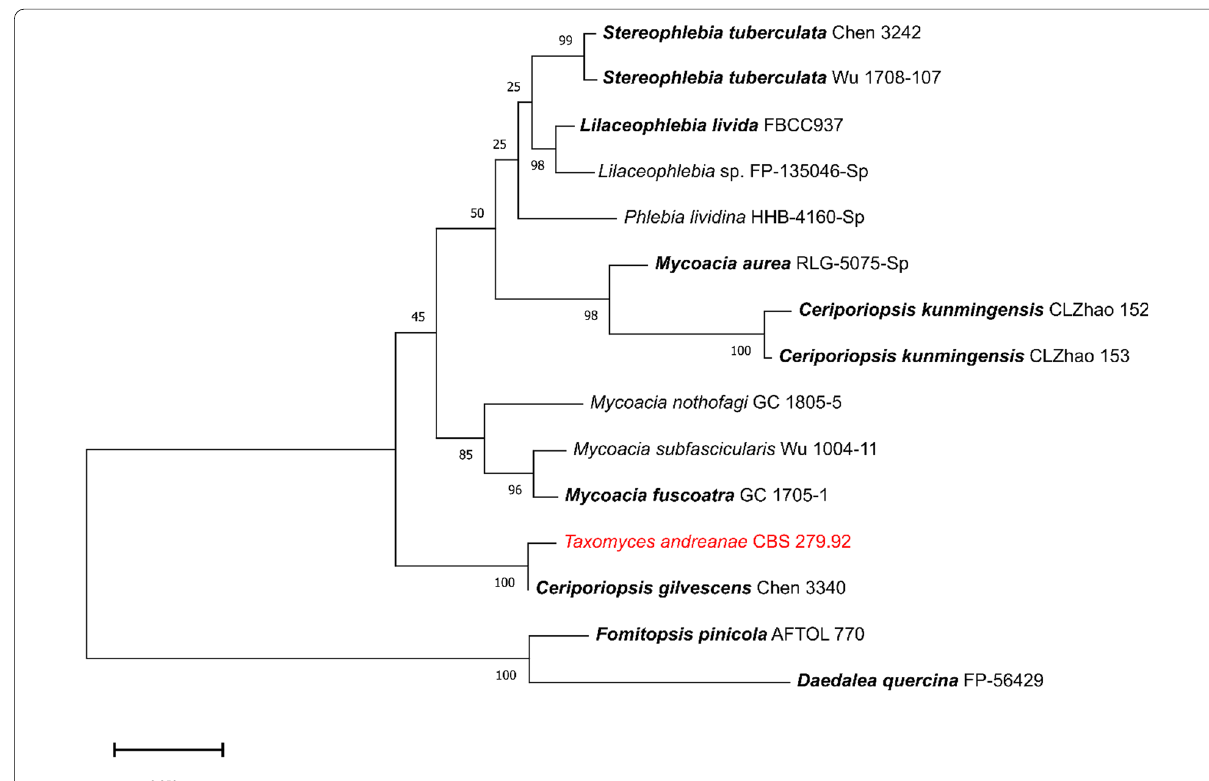
Fig. 1 Phylogram of Taxomyces andreanae and phlebioid species inferred from ML analyses using the combined ITS sequences retrieved from a BLAST search. The type species of the respective genera are printed in bold, even though most sequences are not derived from type or epitype